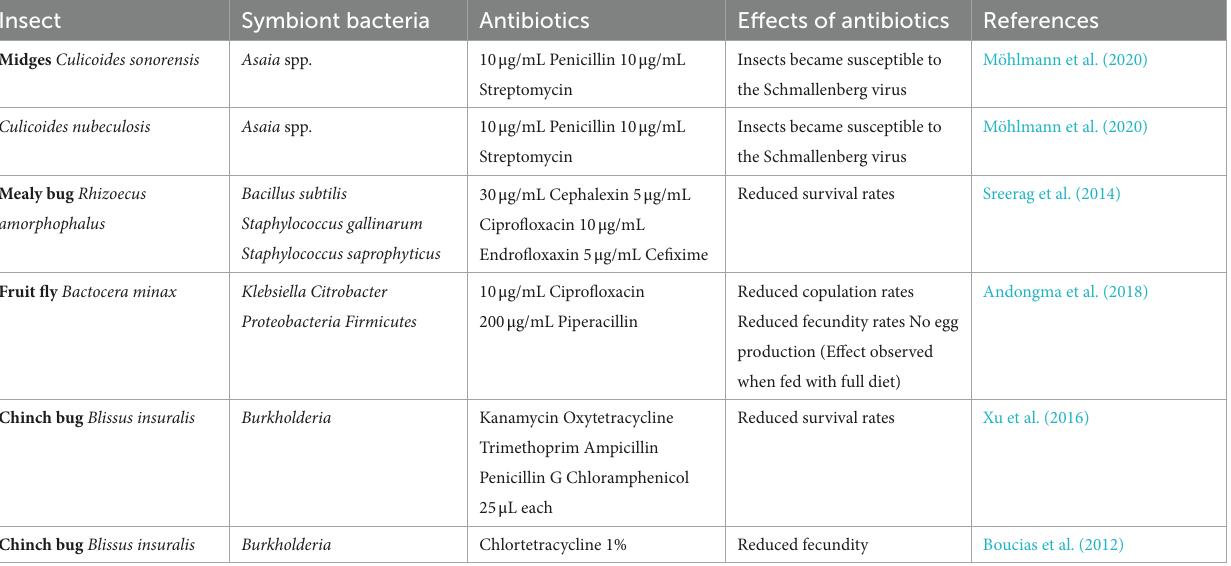
TABLE 3 Antibiotics used against the symbiotic bacteria to check insect